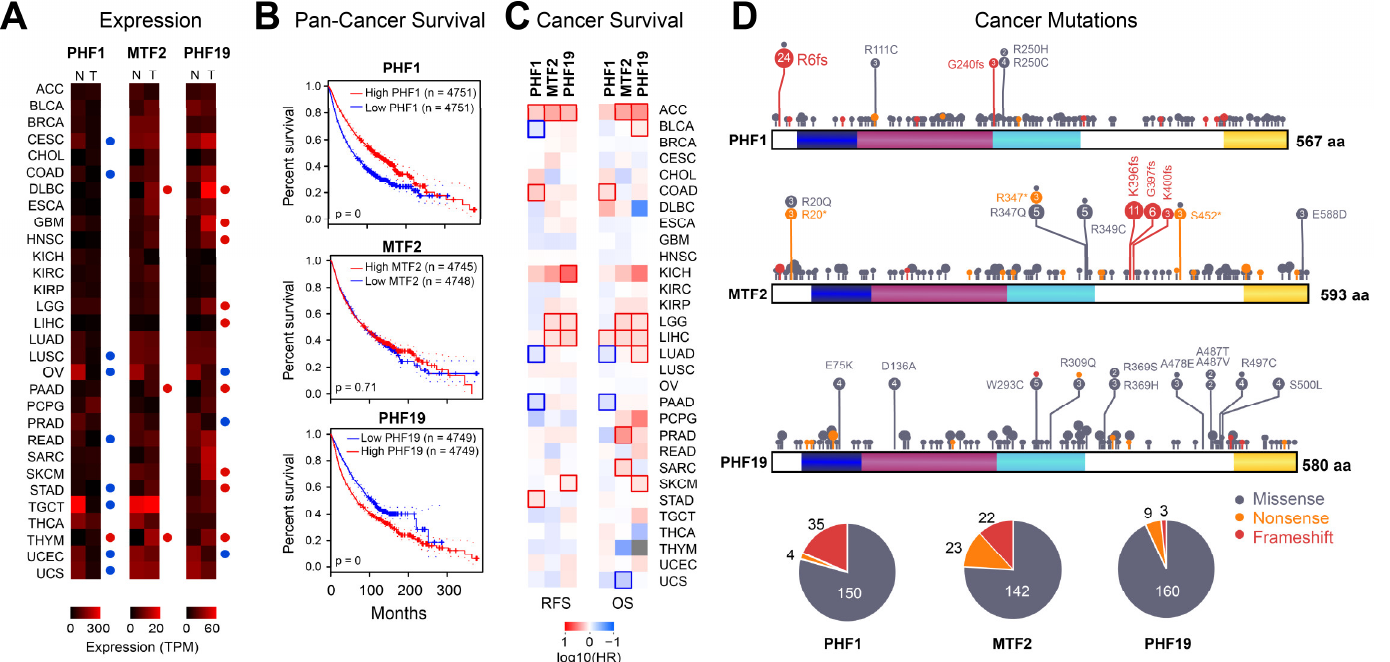
Figure 2. ( A ) Comparison of gene expression of the PCL proteins in normal (N) and tumor (T) tissue. Red and blue circles indicate significantly increased or decreased gene expression in tumor versus normal samples, respectively. ( B ) Kaplan–Meier plot of pancancer patient survival (overall survival) dependent on the expression of PHF1, MTF2, and PHF19. The data were split based on median expression. ( C ) Survival plots showing the hazard ratio (HR) for the three PCLs for individual cancer types. RFS = relapse free survival and OS = overall survival. Cancers with rectangles indicate a sig- nificant difference in survival between low and high expression. Data from TCGA [48] and visual- ized by GePIA [49]. ( D ) Mutations of the three PCL proteins, based on the COSMIC database [47]. Visualized using ProteinPaint [50]. * = mutation to a stop codon, fs = frameshift mutation. The pie charts show the relative distribution of missense, nonsense, and frameshift mutations for each PCL protein.